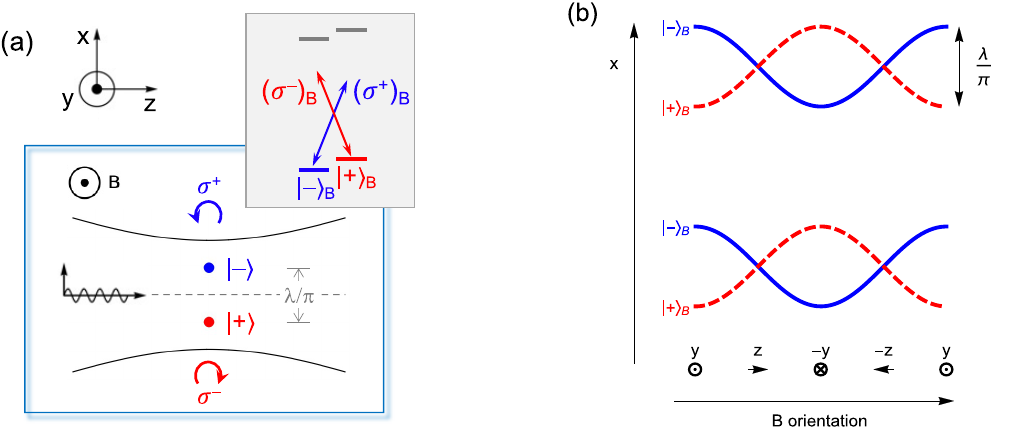
Figure 4: Spin dependent displacement and motion in optical tweezers. (a) Optical tweezer operating on a j = 1 ∕ 2 → j ′ = 1 ∕ 2 transition, leading to ±λ off-axis displacements for the | ∓ ⟩ sublevels. (b) Spin-dependent motion of atoms in the tweezer, effected by a rotation of the quantization axis ( B ) through cycles of traps move up and down along the x axis, in antiphase. The figure shows the situation of two y → z → − y → − z → y . The locations of the | ± ⟩ B separate, closely spaced optical tweezers. This may open up possible applications in interferometry, or, in the presence of distance-dependent interaction, quantum gates. If B is rotated at the trap frequency, spin-dependent oscillatory motion in the tweezer can be